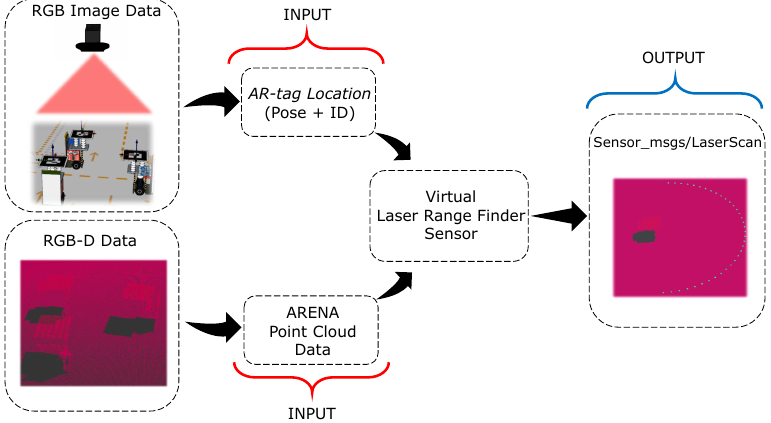
Figure 9. Proposed approach to virtual